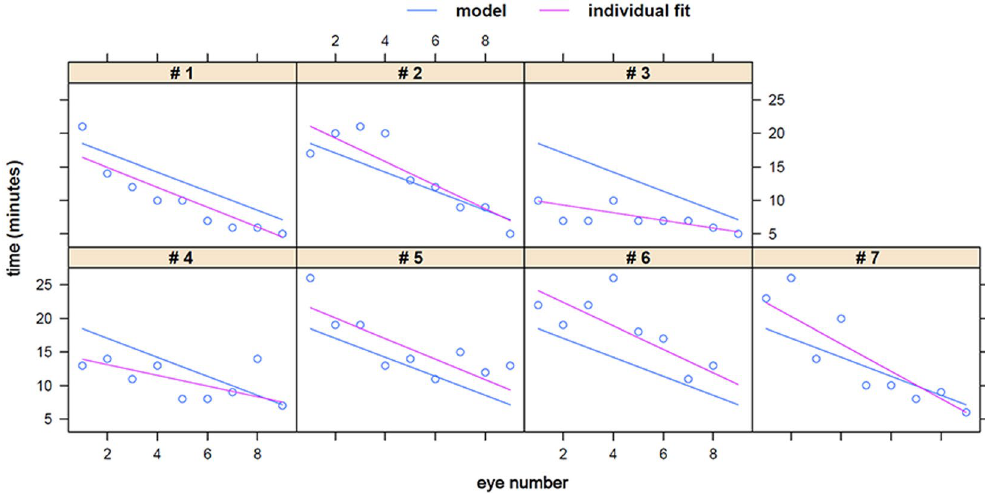
Figure 3. Surgical time and eye number. The relationship of eye number and time for each trainee followed a linear